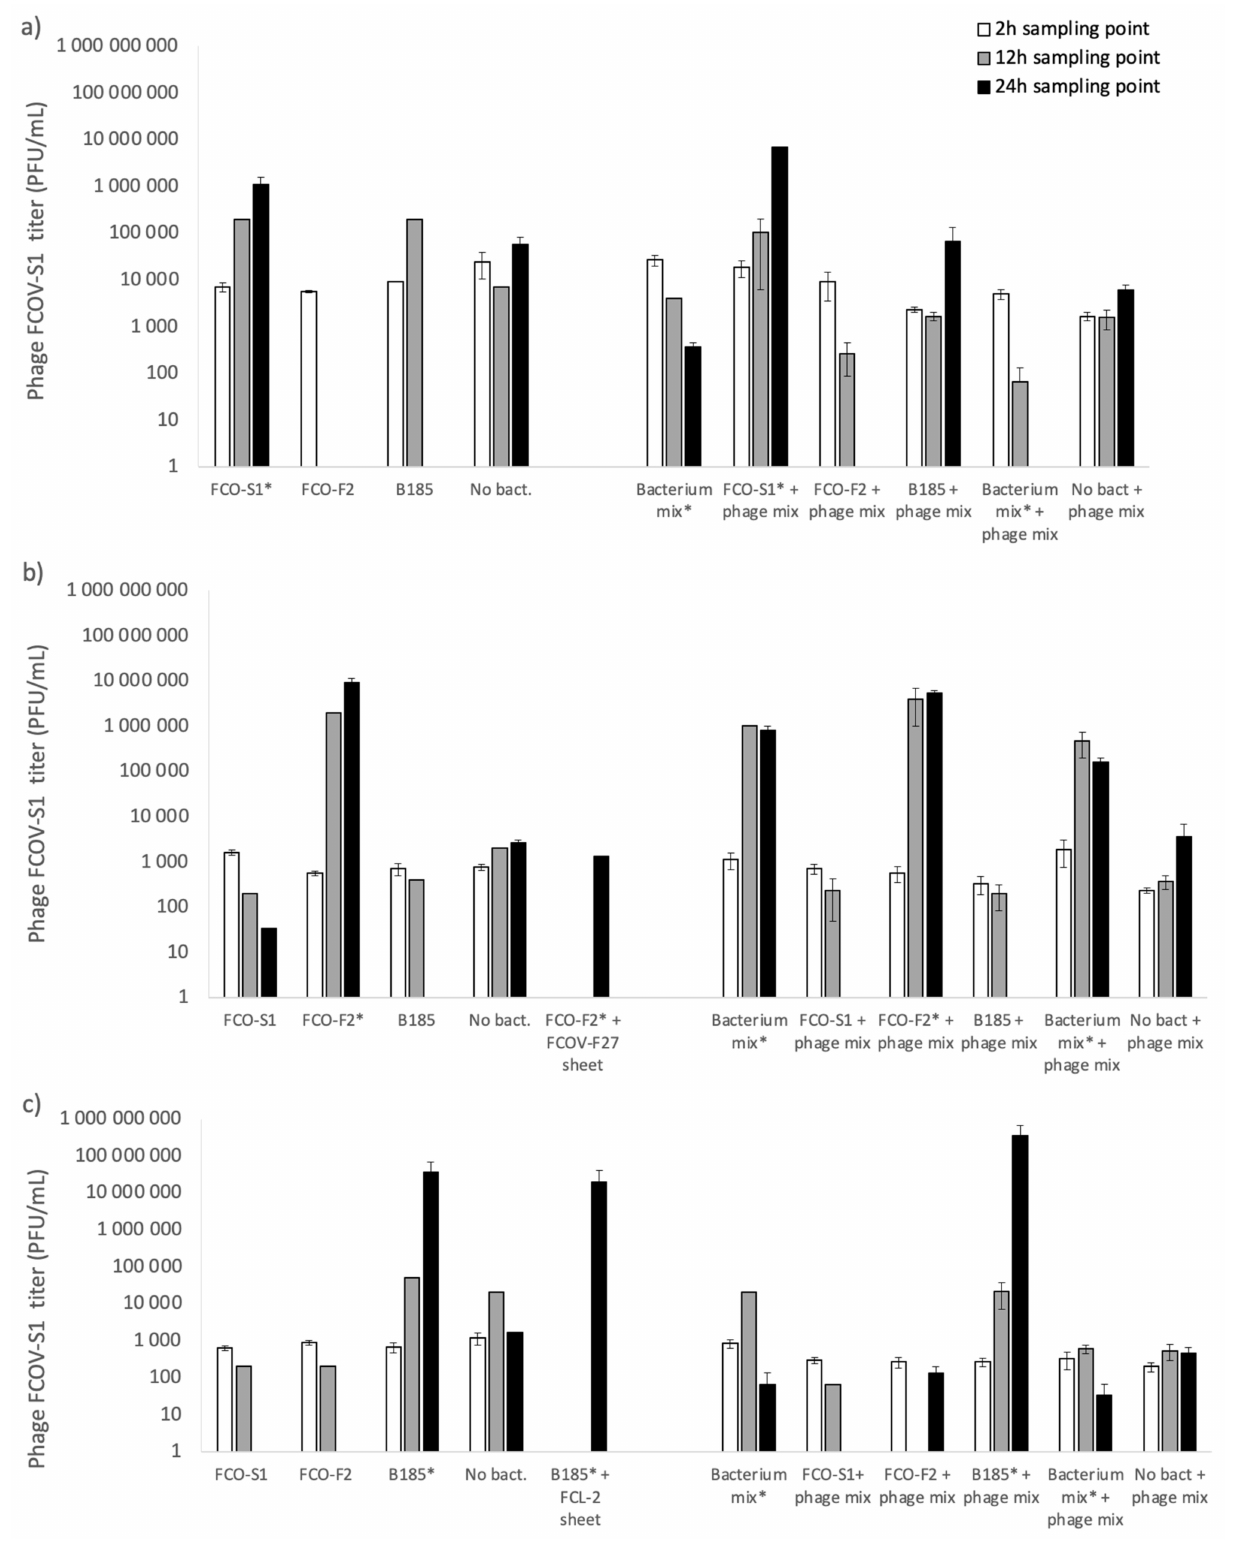
Figure 2. Mean titers (PFU mL − 1 ) of phages ( a ) FCOV-S1, ( b ) FCOV-F27, and ( c ) FCL-2 in water samples during bacterial infection of rainbow trout with F. columnare strains FCO-S1, FCO-F2, B185, and their mixes. Phage titers were monitored at 0 h (white bars), 12 h (dark grey bars), and 22 h (black bars). Error bars indicate standard error of mean (not available for all 12 h samples). The presence of the phage host is indicated by an asterisk